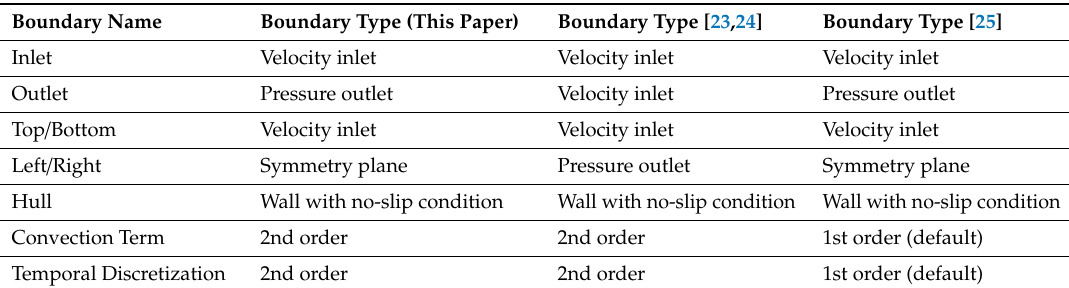
Table 4. Boundary types and solver